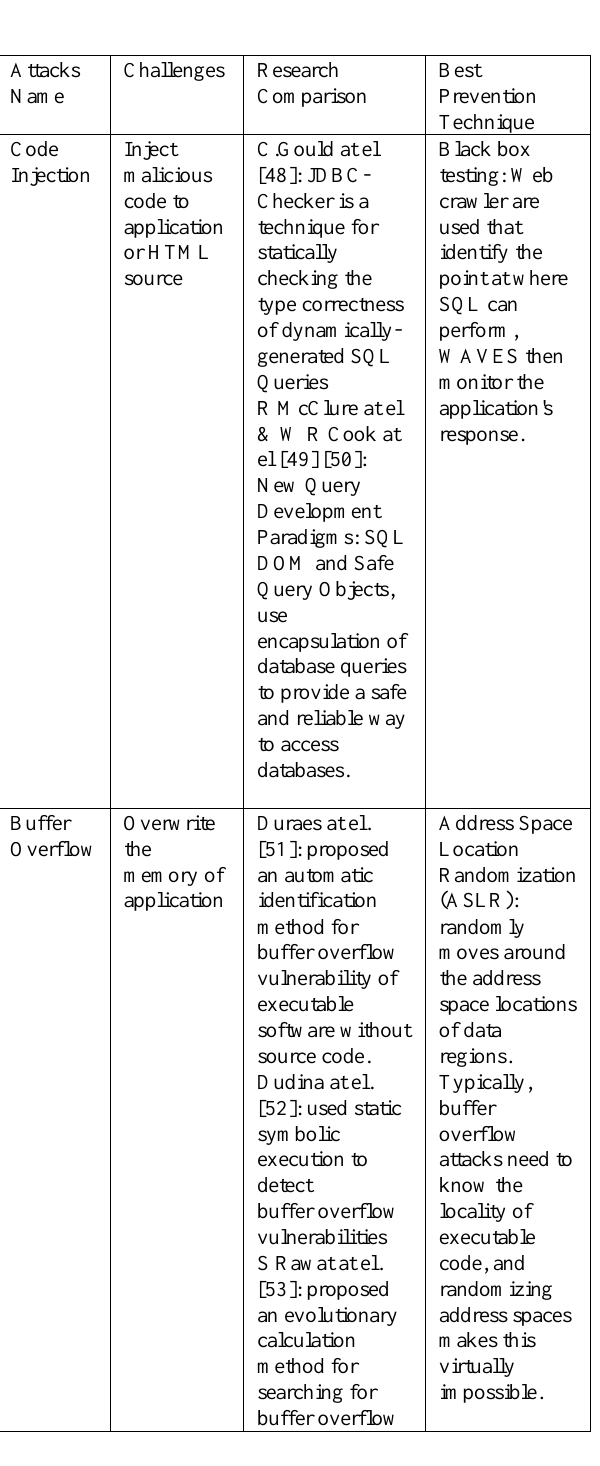
Table 3. Literature Survey of Application